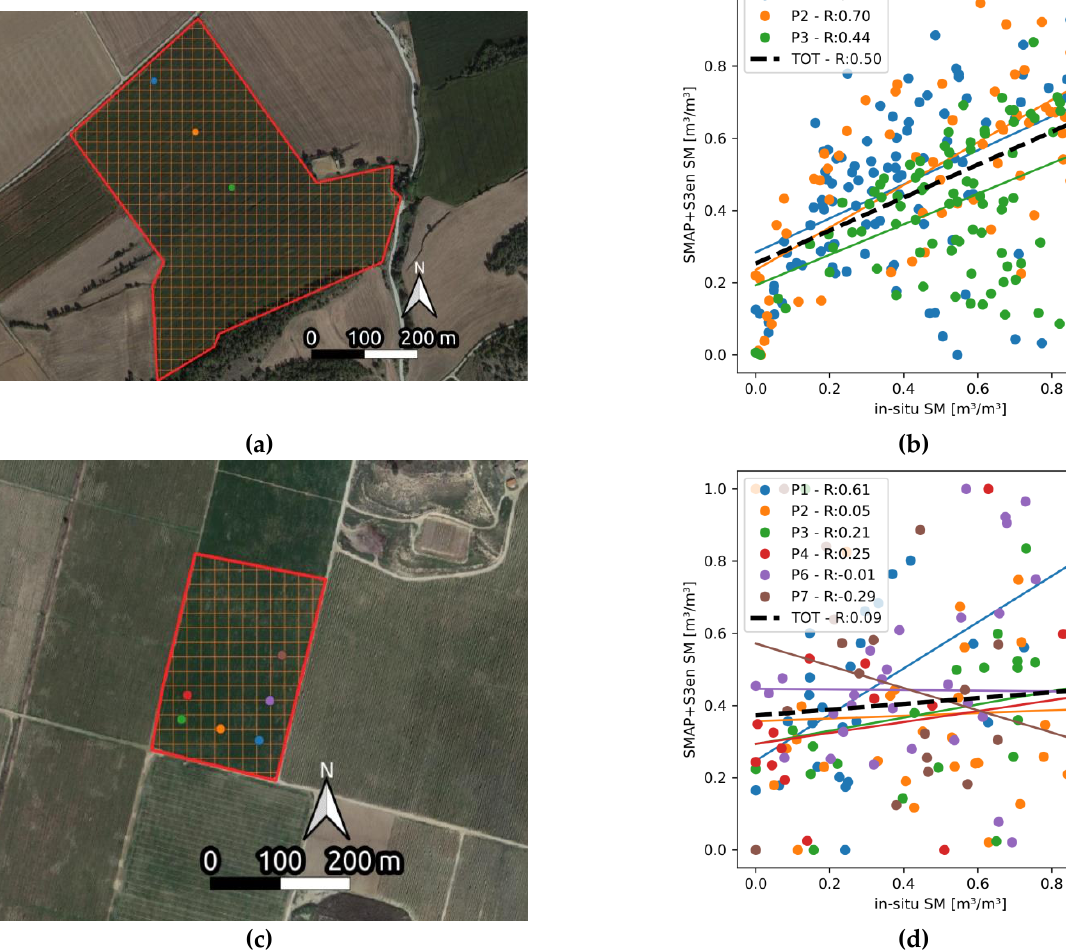
Figure 6. Sub-field scale correlation analysis: ( a ) position of the three in situ sensors in the Foradada field and pixel sizes of the SMAP + S3en SSM product. ( b ) Scatter plot of SMAP + S3en SM data at pixel level vs the in situ data for each single sensor for the Foradada field. ( c ) Position of the six in situ sensors for the Raimat field and pixel sizes of the SMAP + S3en SSM product. ( d ) Scatter plot and correlations for each location of the sensors for the Raimat field.